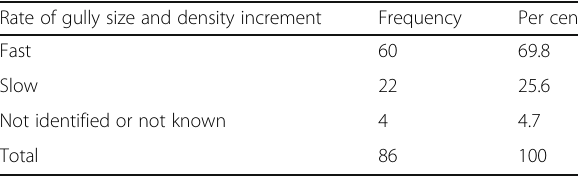
Table 8 Perception of farmers on the rate of gully development Rate of gully size and density